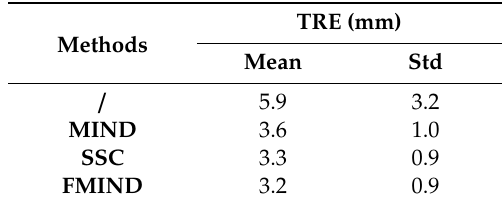
Table 8. The TRE for the MIND, SSC, and FMIND methods operating on the real US-MR images of 13